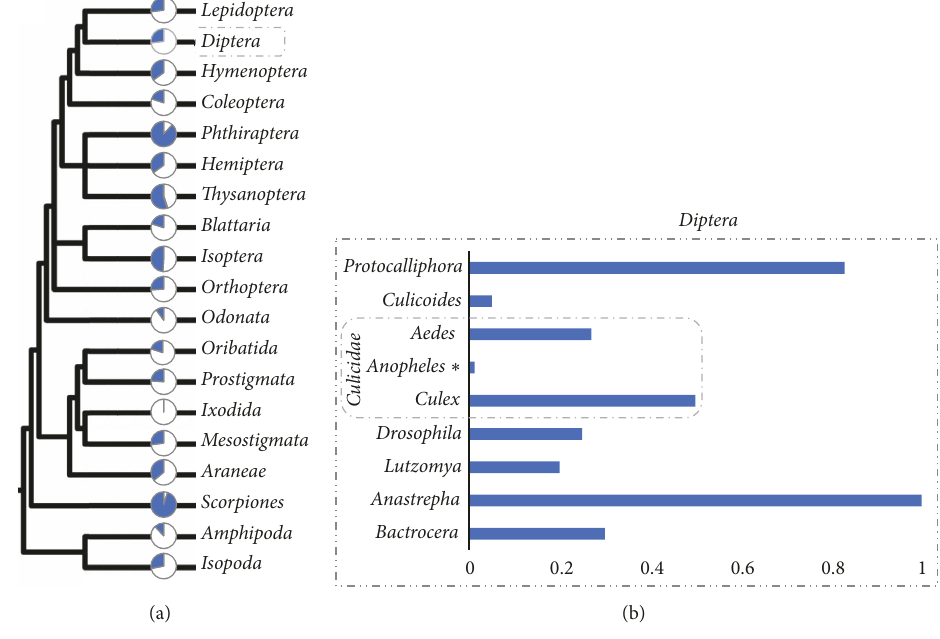
Figure 4: Wolbachia in arthropods . (Modified from Russell & Steiner 2012, Myrmecological News Journal [57]). (a) Graph illustrating Wolbachia -infected (Blue shaded portion) and Wolbachia -uninfected (white portion) proportions by host taxon. (b) Histogram highlighting the frequencies Wolbachia infection of some dipteral families. The asterisk ( ∗ ) indicates the recent discovery of native Wolbachia within the Anopheles genus.